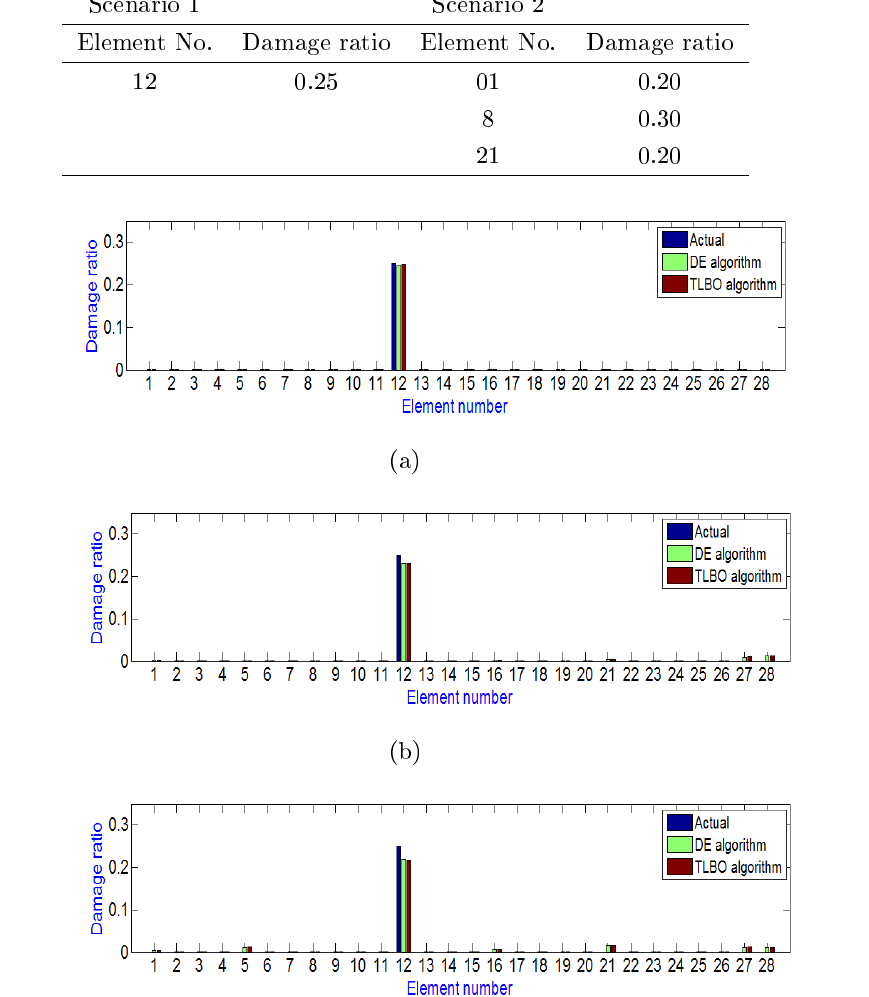
Table 1. Single and triple damage scenarios induced in the steel 2D structure.